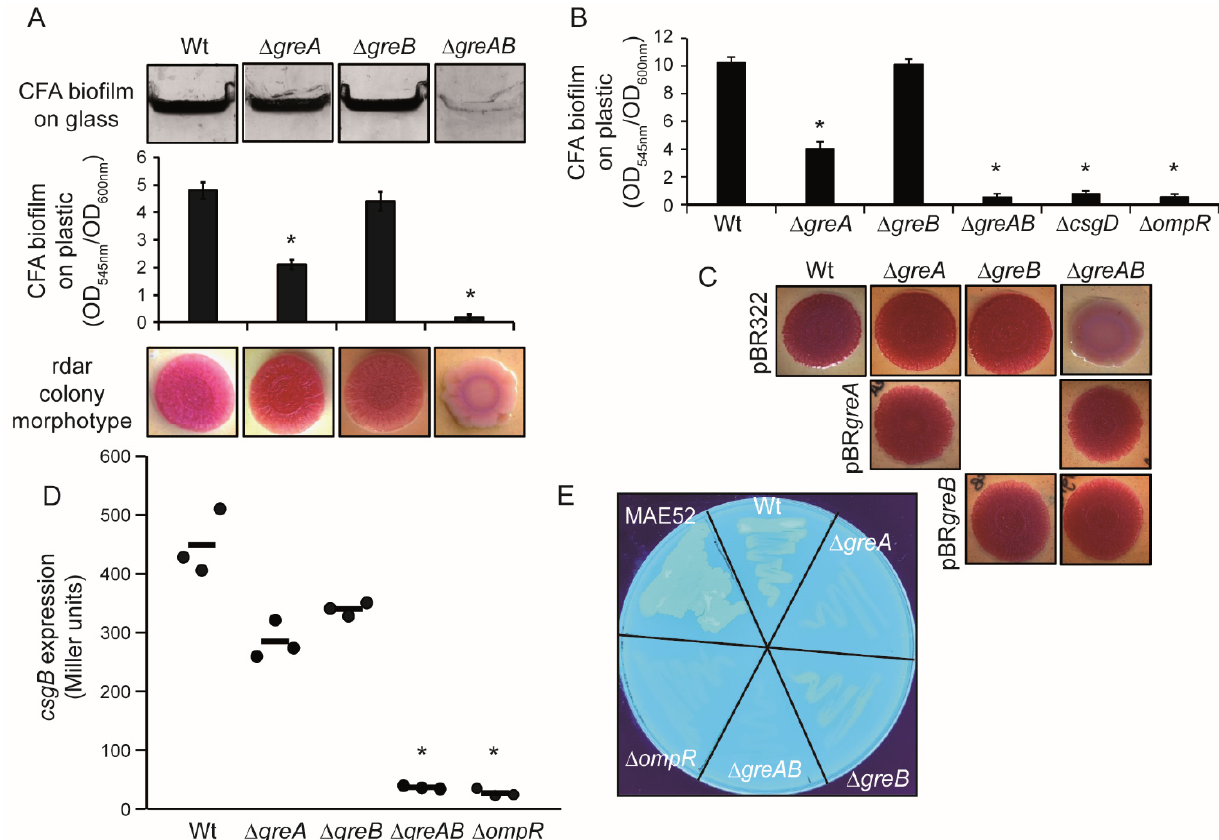
Figure 1. The Gre factors are required for expression of rdar biofilm promoting factors in S. Typhimurium. ( A ). Effect of deletion mutations of Gre factor encoding genes on the biofilm formed by the SV5015 strain. Upper panel, crystal violet stained biofilm formed by SV5015 (Wt) and the indicated mutant derivatives strains on glass slides after static growth for 72 h at 25 °C in CFA medium in Hellendahl jars. Middle panel, quantification of crystal violet stained biofilm formed on polystyrene walls of 96 well plates in CFA medium after 72 h at 25 °C. Lower panel, colony morphotype of the indicated strains on Congo red plates. ( B ). Effect of deletion mutations of the Gre factor encoding genes on biofilm formation by the UMR1 strain formed on polystyrene walls of 96 well plates. Cultures and quantification were performed as in ( A ). Biofilm quantification, in both ( A , B ), is based on calculation of the mean and standard deviations of six samples (three independent cultures with two technical replicas each). ( C ). Trans-complementation of the UMR1 Δ greAB mutant strain monitored by colony morphotype on Congo red plates carrying either the pBR322 (control vector), pBRgreA or pBRgreB. ( D ). Transcriptional expression of a csgB::lacZ chromosomal fusion was monitored in the indicated strains by β -galactosidase determination. Mean and standard deviations calculated from three independent cultures are shown. ( E ). The production of cellulose is impaired in the Δ greAB mutant strain. Observed fluorescence under UV of the indicated strains grown at 25 °C for 48 h on a LB 0 plate supplemented with calcofluor. Statistically significant difference compared to Wt is shown by an asterisk ( p < 0.0005).